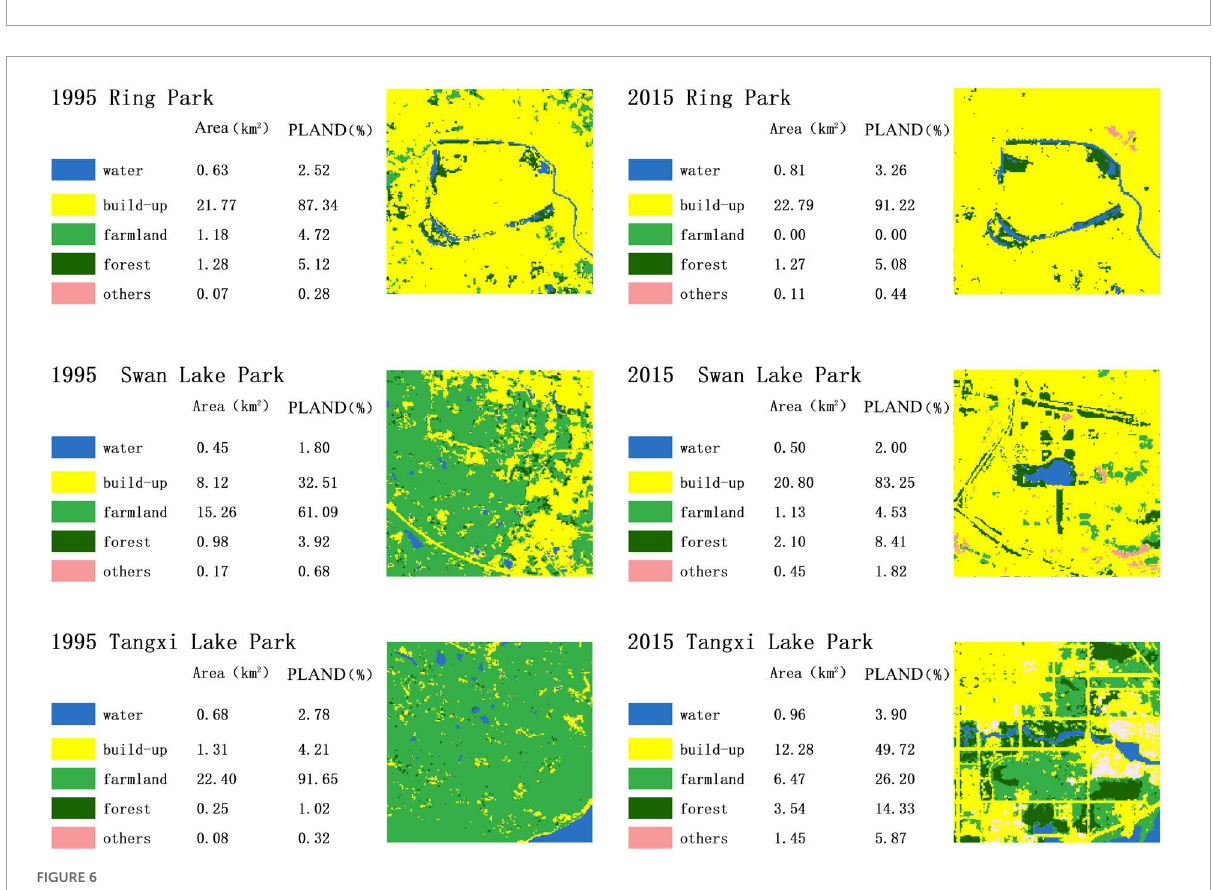
ring varied significantly. From Ring Park to Ring 4, the number and area of urban parks are increasing. There were 244 parks with a total area of 73.35 km 2 . The regional park occupies the largest proportion of the area among all types, with a total area of 55.39 km 2 , accounting for 75.51%. There were 66 parks in total, mainly distributed in Rings 2, 3, and 4, with 16, 22, and